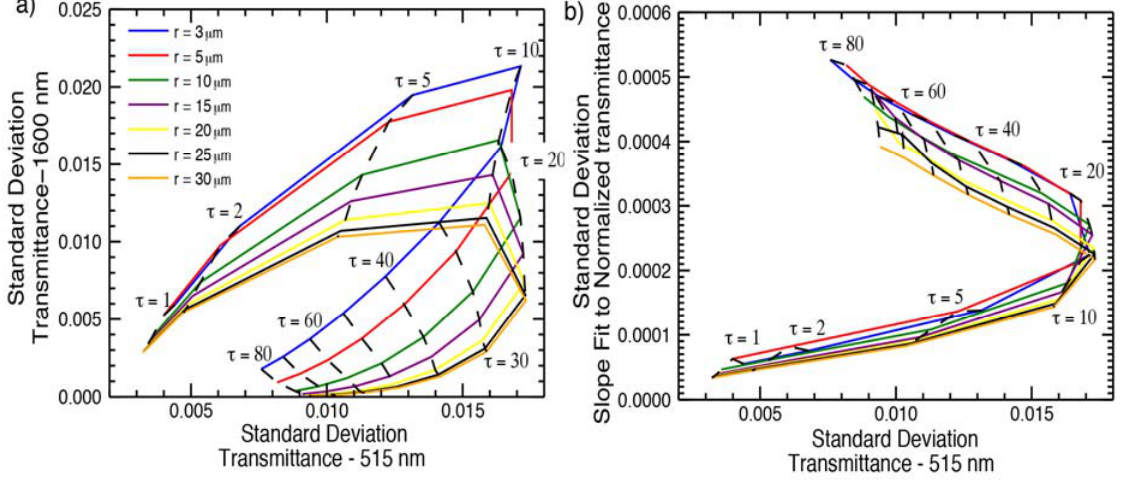
Figure 5. Standard deviation in transmittance as a function of τ and r method and ( b ) spectral slope method due to +3% systematic measurement error and variability in surface albedo spanning bare soil to vegetated surface types. Calculations shown are for μ = 0.866. Plot details are as described in Figure 0